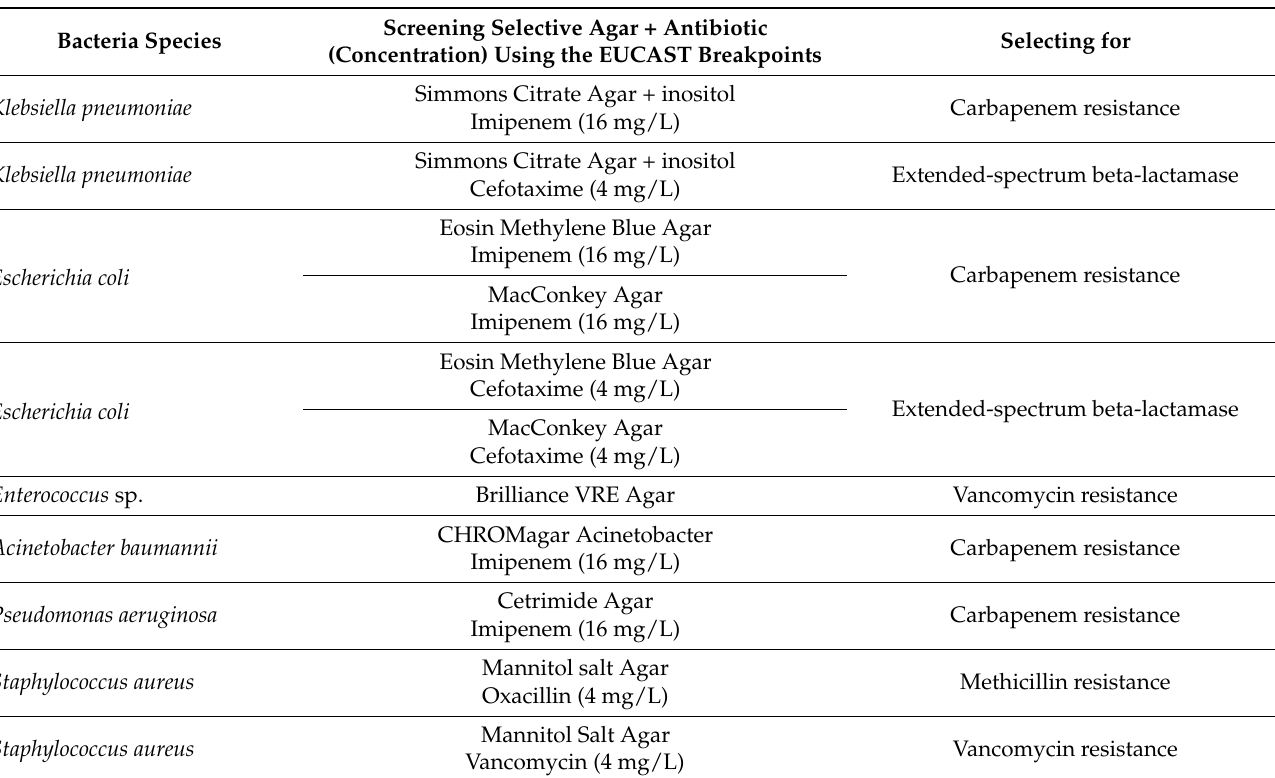
Table 1. Selective agar screening for AMR